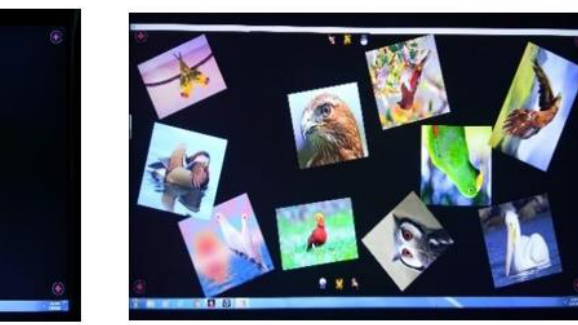
Figure 1. Structured information visualization.